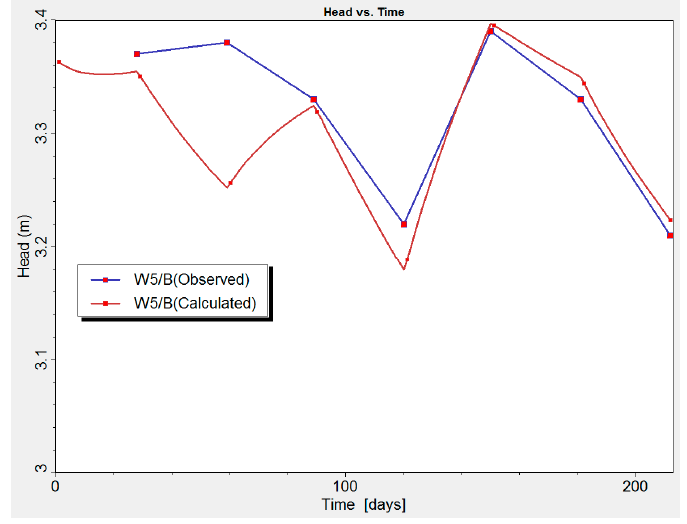
Figure 12. Head versus time at the monitoring piezometer-W5 (Scenario 3).